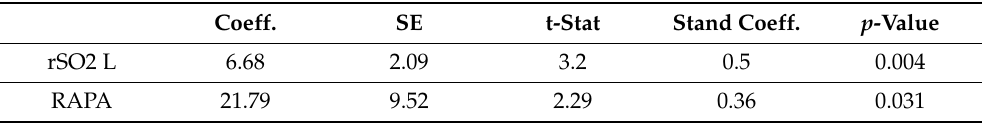
Table 5. CompBased-CAT/rSO2 front L/RAPA multiple linear regression (adjusted R 2 = 0.48; Cognifit = − 109.901 + 21.790 RAPA + 6.681 rSO2 front L).